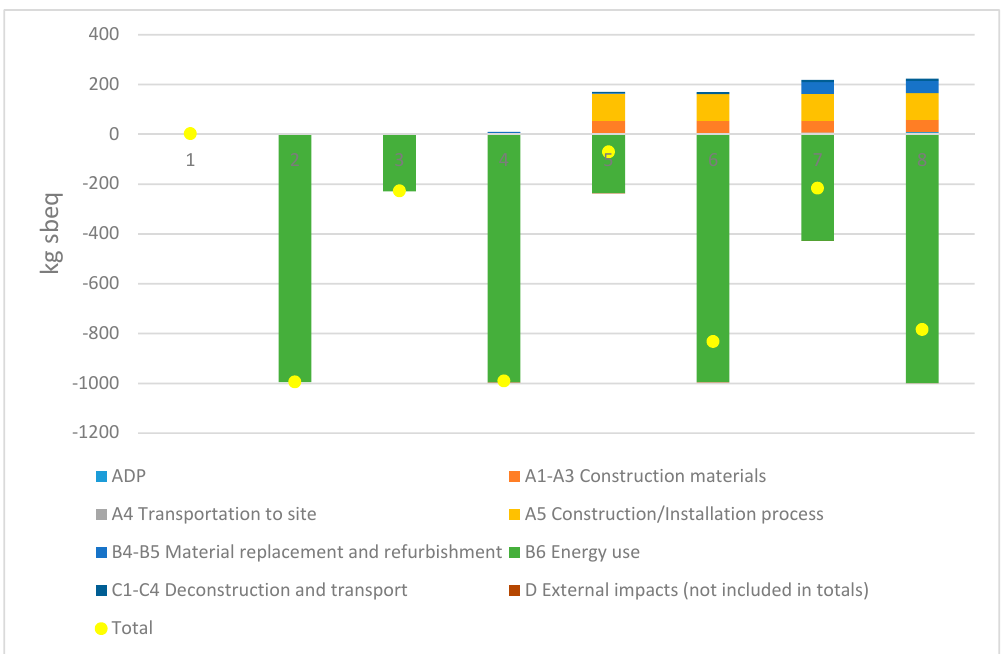
Figure 2. Abiotic depletion potential (ADP) of nonfossil elements (Sbeq).